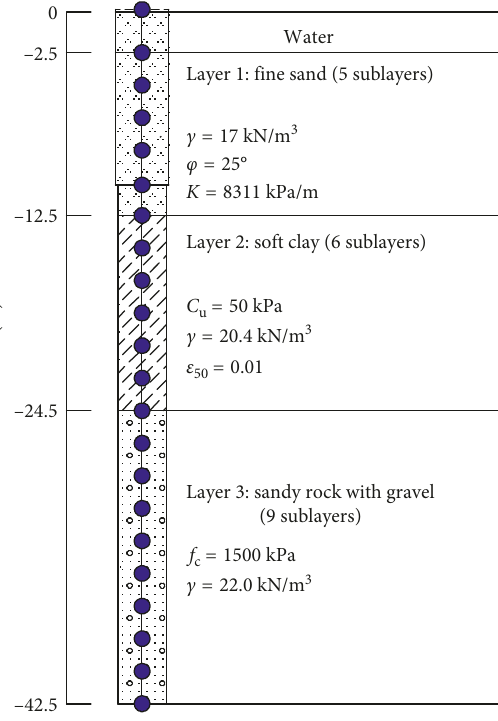
Figure 2: Soil profile and